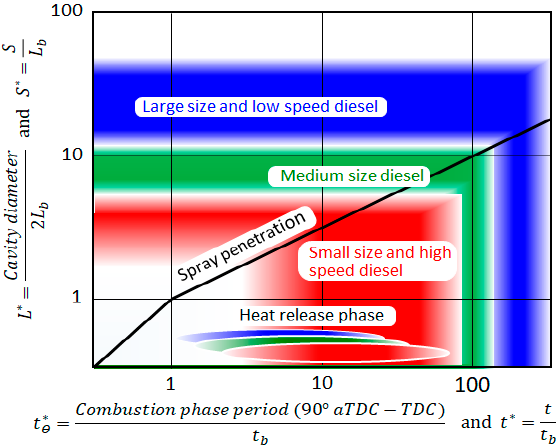
Figure 37. Breakup scaling of spray tip penetration, combustion phase, and engine size.